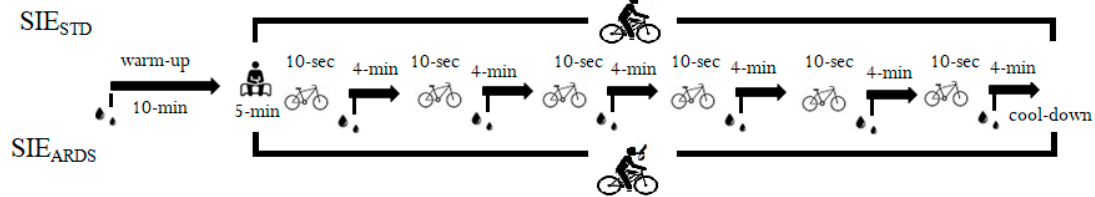
Figure 1. Cycling sprint interval exercise (SIE) protocol SIE STD —standard protocol, SIE ARDS —protocol with the added respiratory dead space volume.